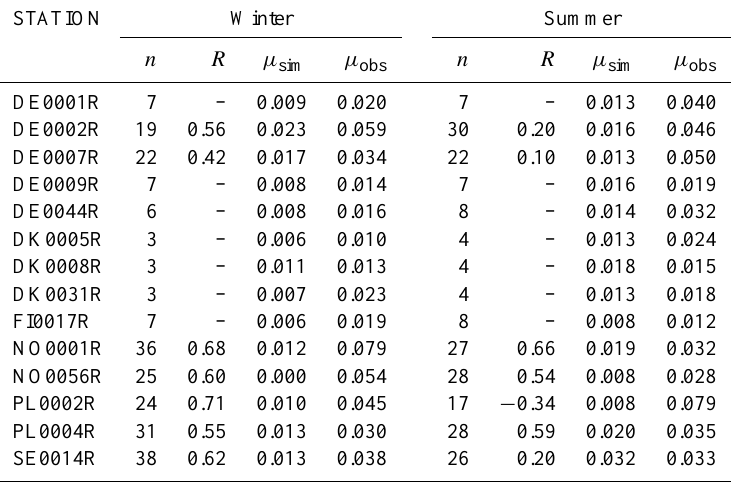
Table 7. Similar to Table 2 but showing R and mean values of model ( µ sim ) and observational data ( µ obs ) of nitrogen wet deposition (kgNha − 1 d − 1 ) for the base case. Reduced nitrogen and oxidized nitrogen are not shown individually. R of time series with a length of 10 or shorter is not shown. The length of the measurement intervals at the individual stations varies between 1 day, 1 week, and 2 weeks. Therefore, the number of measurements intervals for the comparison differs considerably between the